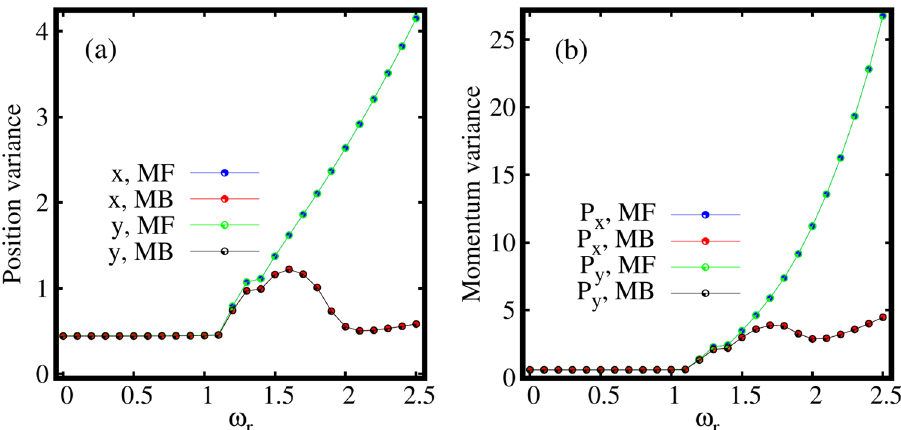
Figure 9. Dependence of the the many-particle position and momentum variances on the rotation in the three-fold symmetric trap. Shown are ( a ) 1 N (cid:31) 2 ˆ X and 1 N (cid:31) 2 ˆ Y and ( b ) 1 N (cid:31) 2 ˆ P many-body level (MB) [ M = 3 self-consistent orbitals] and at the mean-field level (MF) [ M = 1 self-consistent orbital]. All quantities shown are